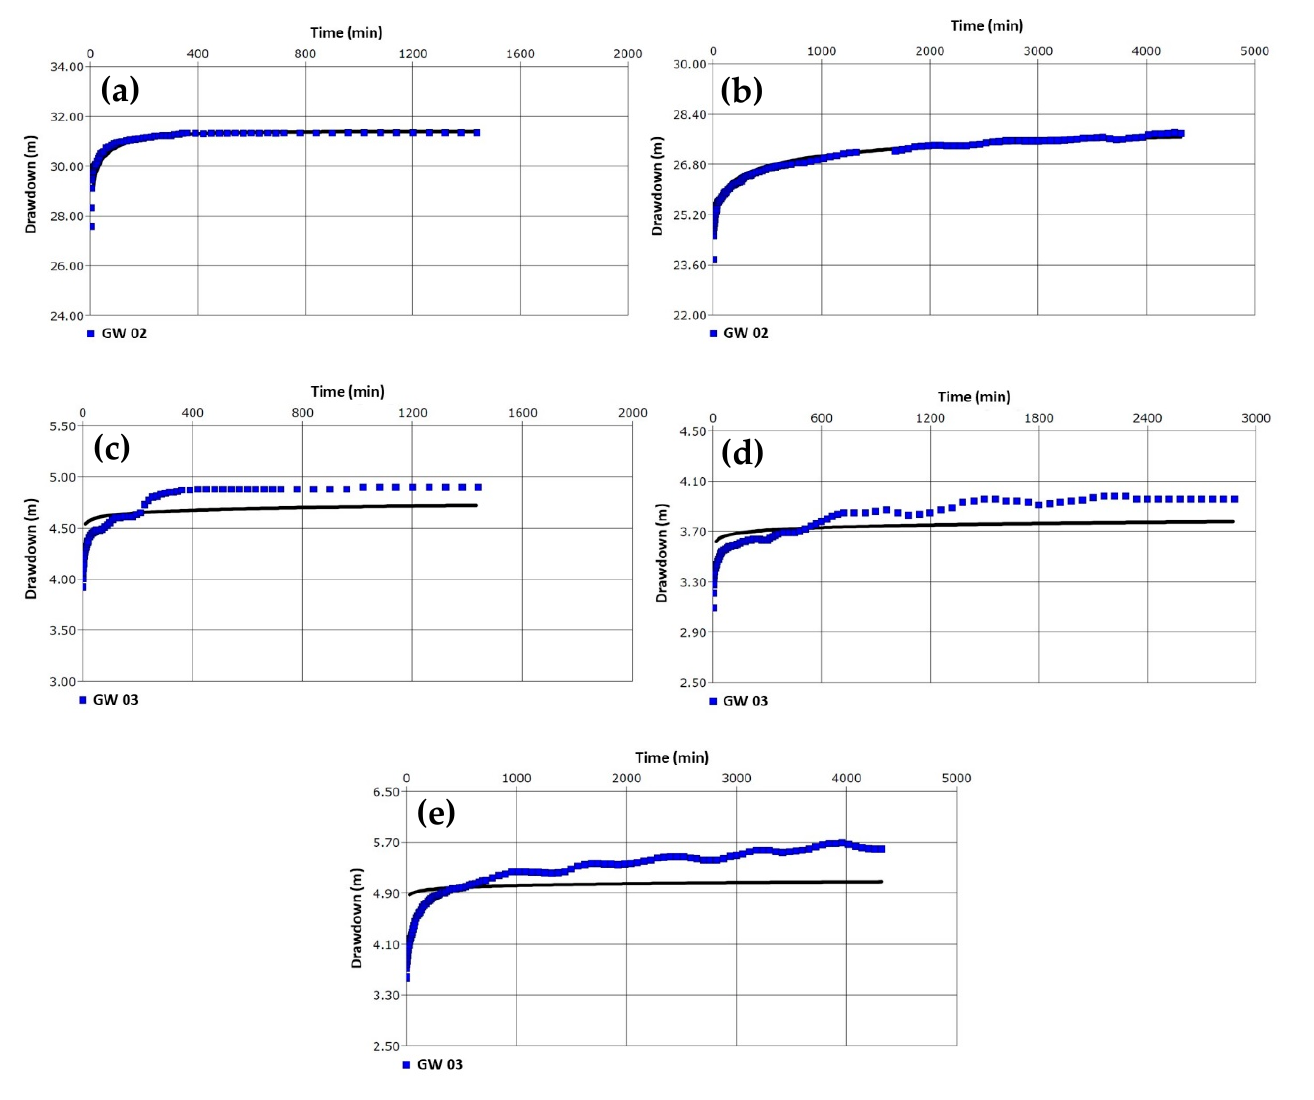
Figure 12. Continuous pumping test curves of leaky aquifer (aquifer B): GW 02 for 24 h ( a ) and 72 h ( b ), and GW 03 for 24 h ( c ), 48 h ( d ), and 72 h ( e ).